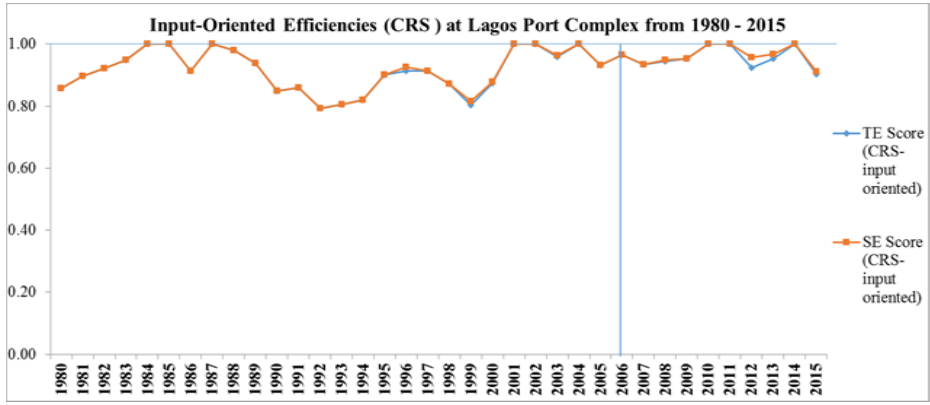
Figure 1: CRS – Technical Efficiency (input-oriented) and CRS – Scale Efficiency (input-oriented) at Lagos Port Complex from 1980 –